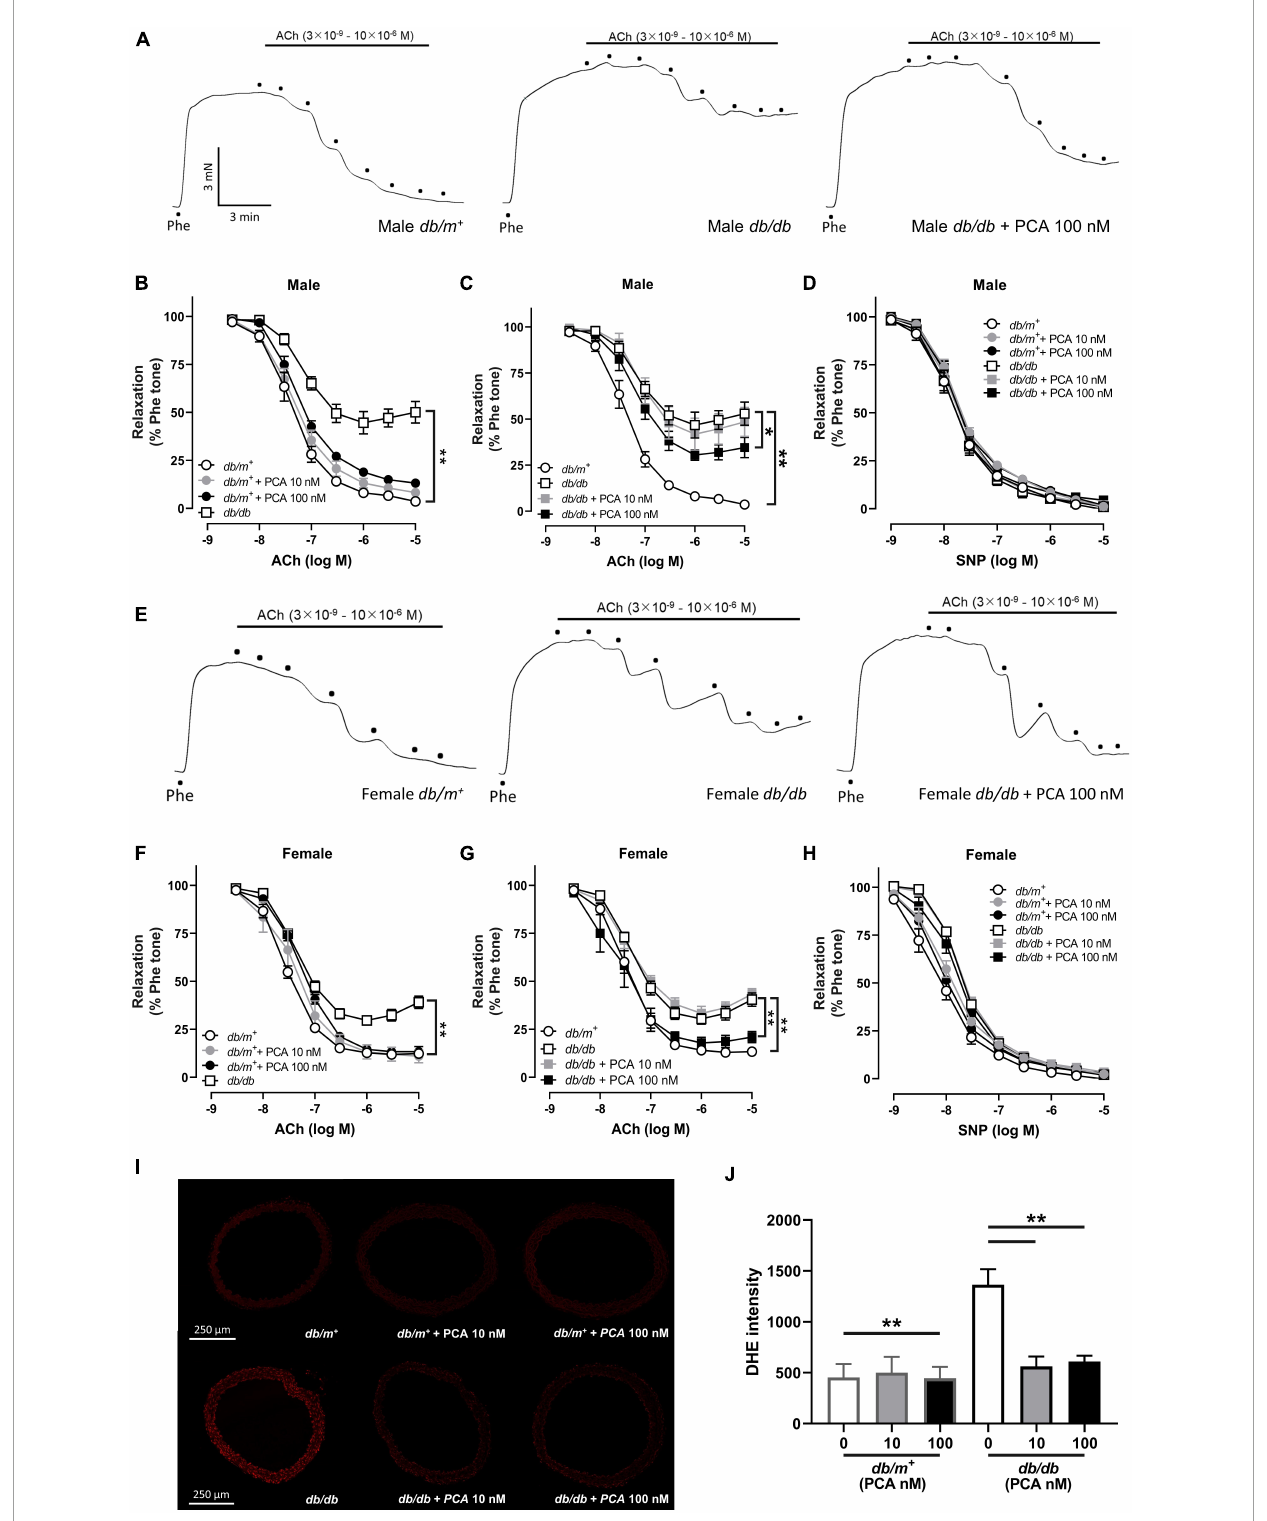
FIGURE1 Direct PCA incubation improved the endothelium-dependent relaxation (EDR) impairment in both male and female db/db mouse aortas with ROS suppression. Representative tracings (A) with summarized data (B,C) of EDR and endothelium-independent relaxation (D) measured by wire myograph in aortas from male db/m + and db/db mice incubated with and without PCA (10 – 100 nM). Representative tracings (E) with summarized data (F,G) of EDR and endothelium-independent relaxation (H) measured by wire myograph in aortas from female db/m + and db/db mice incubated with and without PCA (10 – 100 nM). Representative confocal images (I) and summarized data (J) of DHE stain intensity in aortic rings from db/m + and db/db mice with and without PCA incubation (10–100 nM). Data are presented in means ± SEM; n = 5; * p < 0.05, ** p < 0.01.